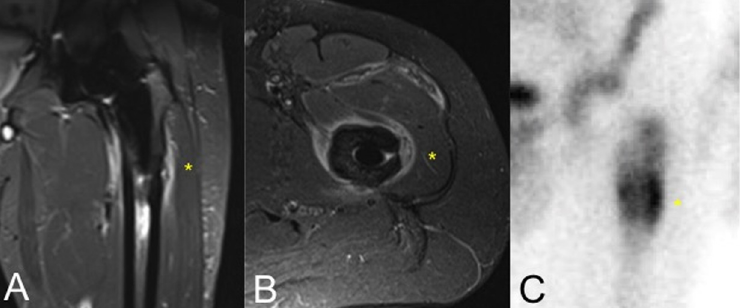
Figure 3. A and B. Fat-Sat magnetic resonance imaging sequences demonstrating intraosseous and periprosthetic bone oedema as well as soft-tissue in fl ammation at the coronal (A) and axial (B) views. C. Triple-phase bone scintigraphy showing high metaphyseal uptake surrounding femoral stem, especially at the lateral femoral cortical (*).